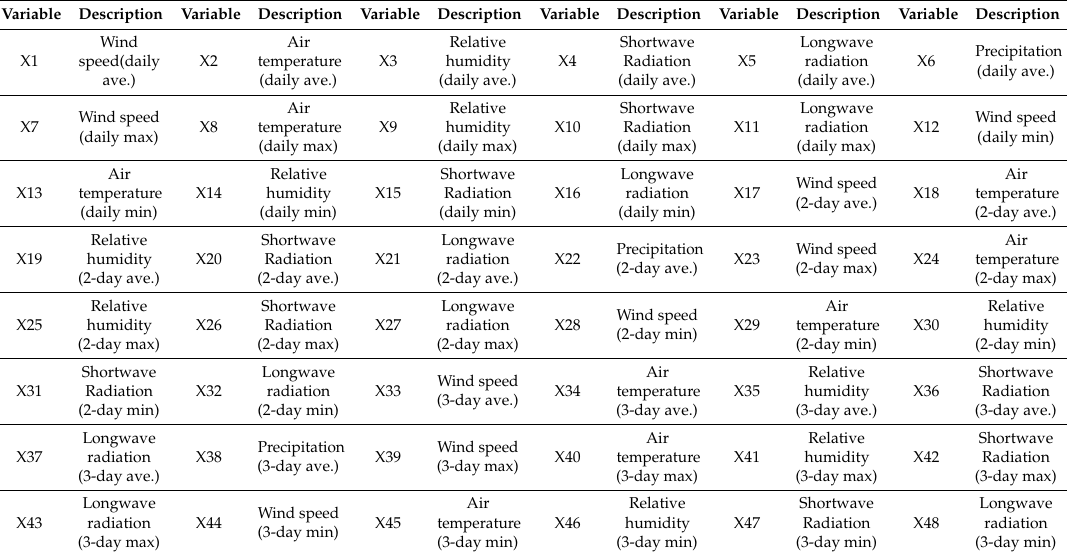
Table 2. Summary of